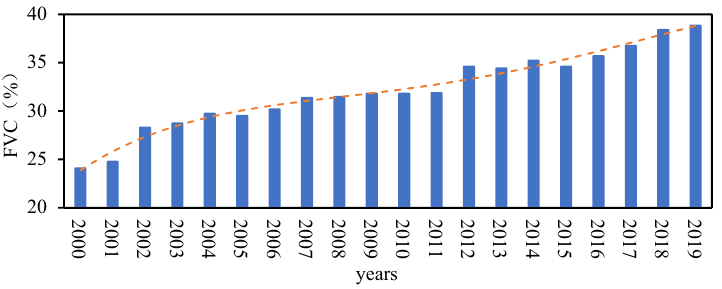
Figure 3. The annual value of FVC in YRB from 2000 to 2019.